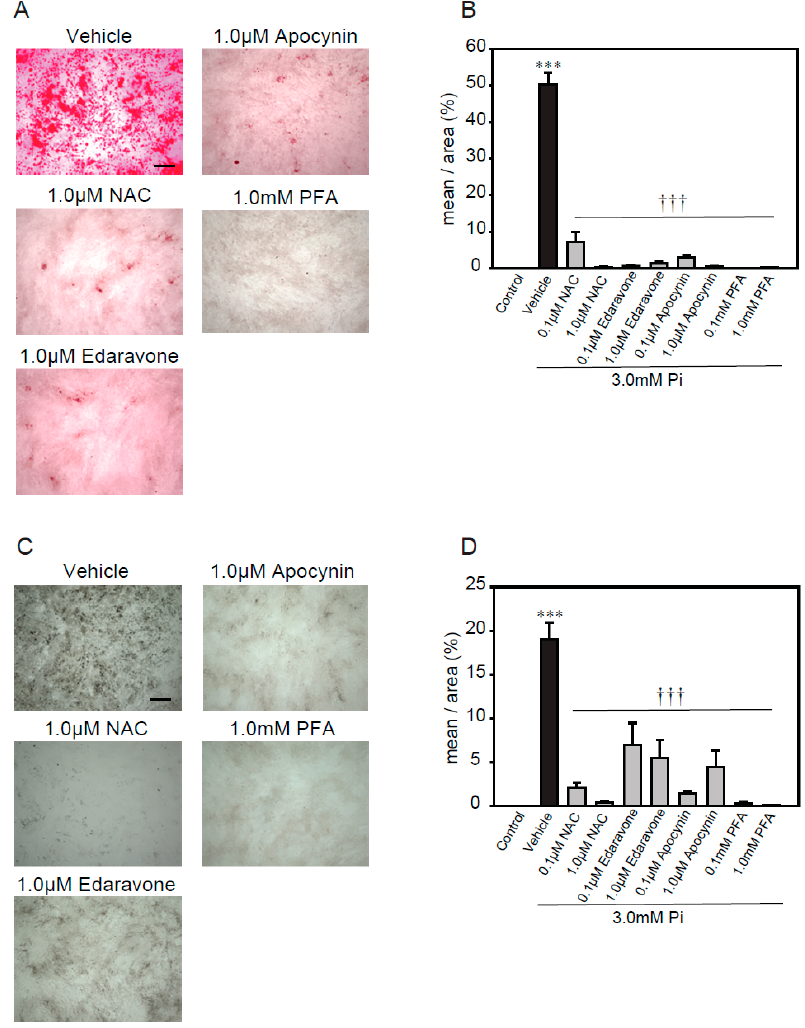
Figure 3. Antioxidants’ protective effects against high Pi ‐ induced calcification. p53LMACO1 cells were cultured with 1.0 mM Pi or FBS (+) medium as a control and 3.0 mM Pi or FBS (+) medium in the presence or absence of various antioxidants for 4 days. ( A , B ) Alizarin red staining. ( C , D ) von Kossa staining. Results are presented as the mean ± S.E.M of five independent experiments. *** p < 0.001 vs. Control, ††† p < 0.001 vs. Vehicle. Scale bar: 500 μ m.